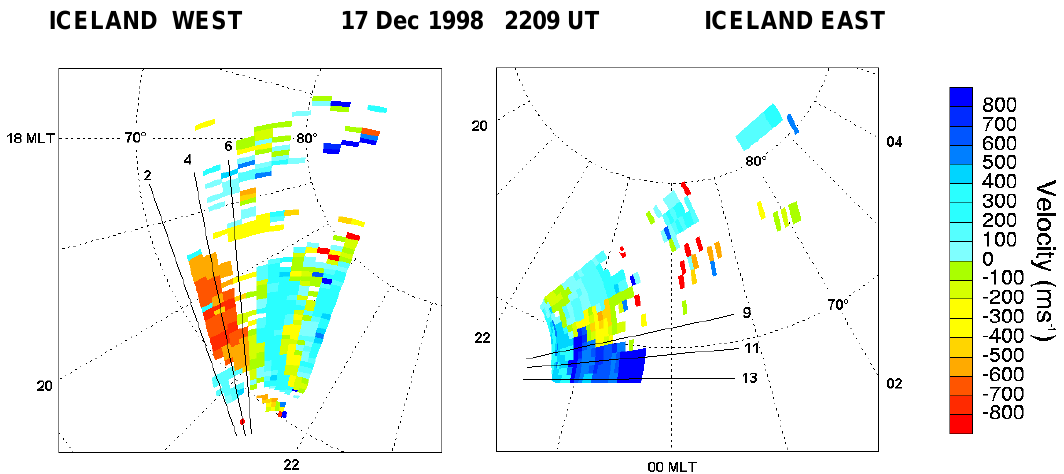
Fig. 4. Radial velocity maps from the two radar in Iceland at 22:09UT (Iceland-West is on the left, and Iceland-East is on the right). The solid lines indicate the directions of the high-time resolution beams along which the data are plotted on Fig. 3. Both maps are consistent with an evening convection cell with sunward flow at low-latitude and anti-sunward flow at high-latitude. The flow bursts are observed in the sunward